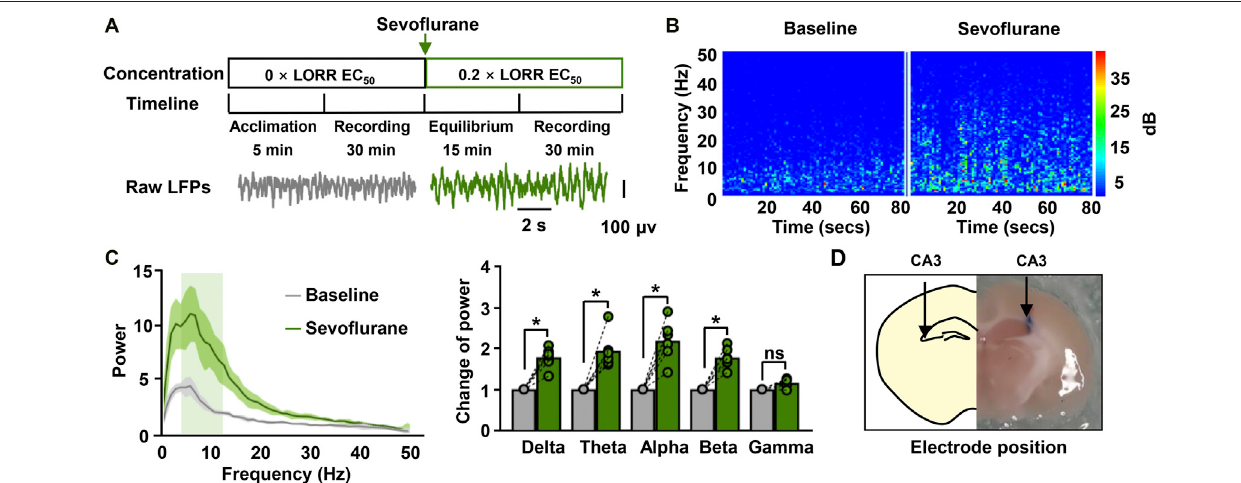
FIGURE 2 | Hippocampal Local Field Potential (LFPs) for sevo fl urane-anesthetized mice. (A) The timeline for LFP recordings (upper) and the raw traces of hippocampal LFPs in a representative mouse before and during sevo fl urane anesthesia (bottom) . The data were digital- fi ltered to 1 – 50 Hz. (B) Representative hippocampal spectrograms from sevo fl urane-anesthetized mice selected for 80 s. The spectrograms exhibit the frequency content of signals changing with time. The Y -axis indicates the frequency, and the X -axis indicates the time. (C) Representative power spectrum (left) of the LFPs recorded during immobility for mice anesthetizedwithsevo fl urane. Solidlines representmeanvalues,and shadedregions represent95%CIs.Thebargraphs (right) showthechangesintotalpowerineach frequency band compared to the base value. N (cid:2) 6/group. (D) The location of the electrode implanted in the CA3 region of the hippocampus. Values are shown as the mean ± SEM; paired t-tests. * p <